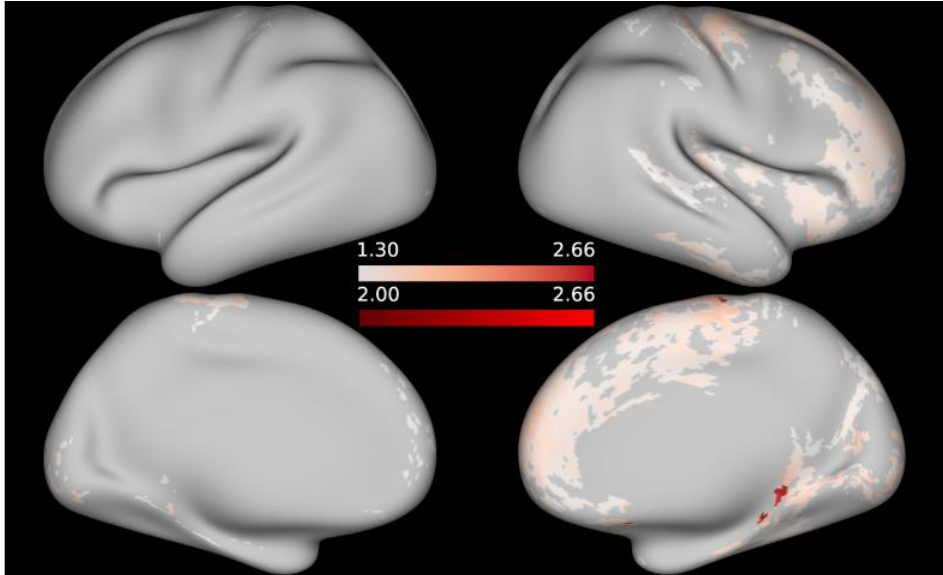
Figure 4. t -statistical map representing areas in which processing speed was positively associated with T1w/T2w contrast. Thresholded at − log10( p ) ≥ 1.3 (pale orange regions), respectively − log10( p ) ≥ 2 (opaque); p -values are uncorrected.